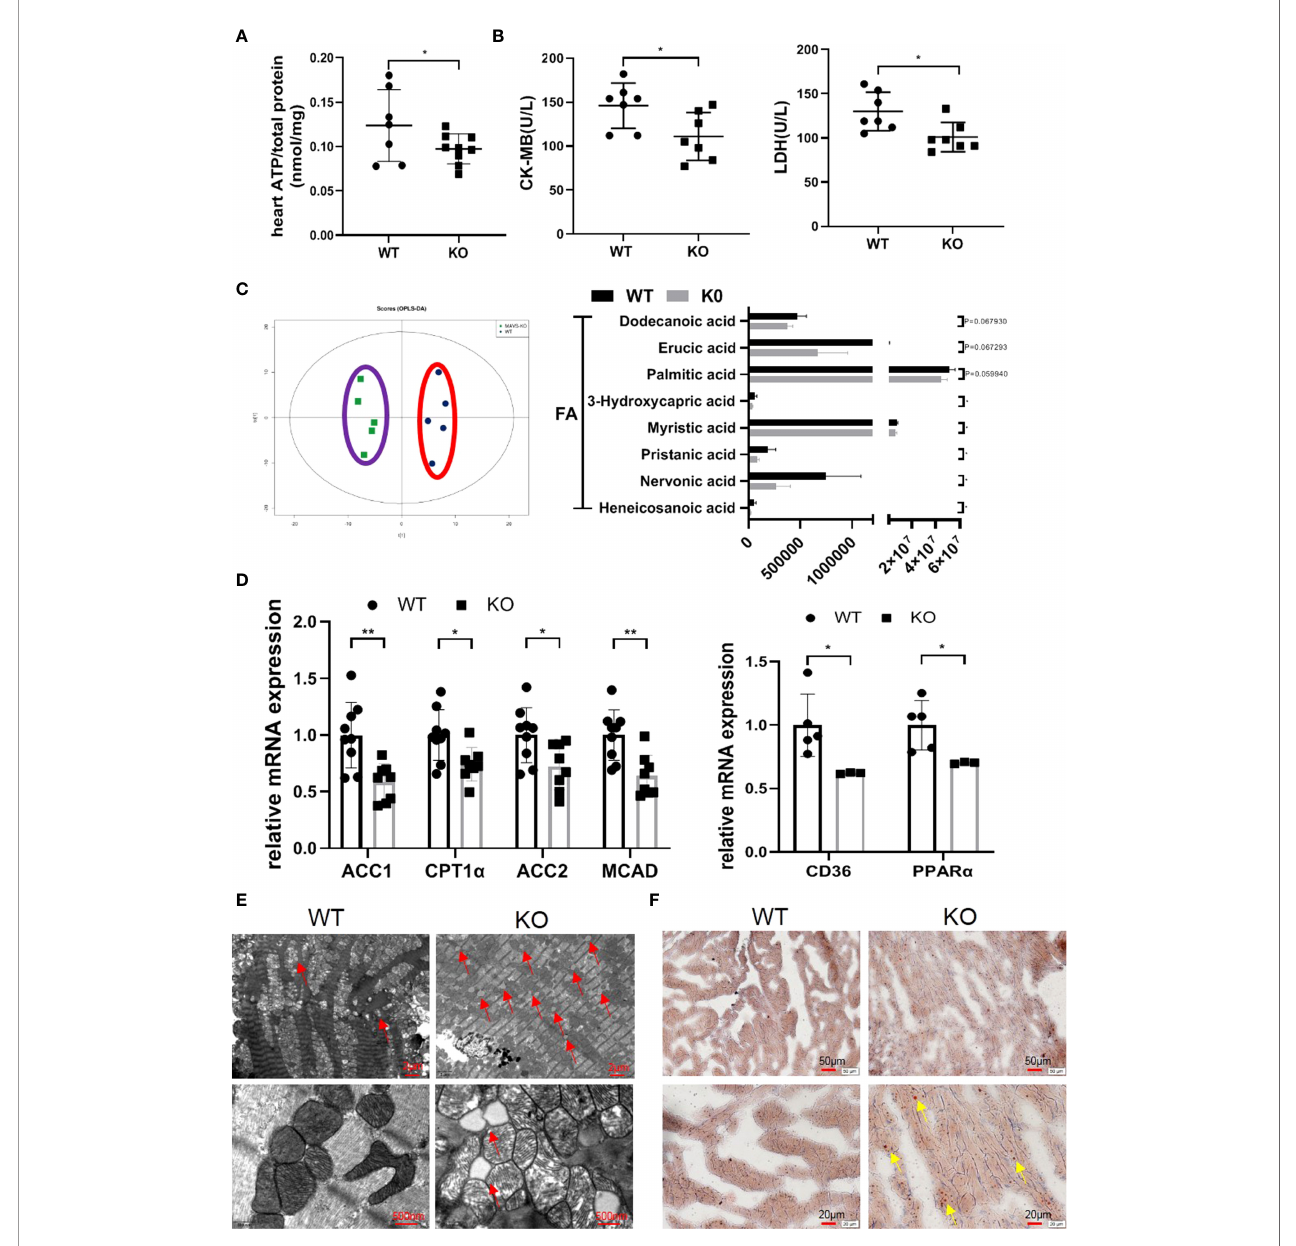
FIGURE 3 | MAVS de fi ciency resulted in energy metabolism disorder by disturbing lipid metabolism. (A) . The ATP content in the hearts of MAVS -/- mice was lower than that in WT mice (n: WT=7, knockout [KO]=9). (B) . Serum CK-MB and LDH levels in WT and MAVS -/- mice (n: WT=7, KO=7). (C) . OPLS-DA analysis based on non-targeted metabolomics was conducted in the hearts of WT and MAVS -/- mice (n: WT=5, KO=5). The levels of some medium- and long-chain fatty acids were decreased in MAVS -/- mice (n: WT=5, KO=5). (D) . RT-qPCR analysis showed downregulation of fatty acid metabolism related genes (ACC1/2, CPT1 a , MCAD) in the hearts of MAVS -/- mice (n: WT=9, KO=8), reduced expression of CD36 and PPAR a (n: WT=5, KO=3). (E) . Representative TEM images of hearts from WT and MAVS -/- mice (Upper panel, scale bar: 2 µm; Lower panel, scale bar: 500 nm, red arrow: lipid droplets). (F) . Representative Oil Red O-stained images of hearts from WT and MAVS -/- mice (Upper panel, scale bar: 50 µm; Lower panel, scale bar: 20 µm, yellow arrow: lipid droplets). The quantitative results are shown as the means ± SEM (*P < 0.05 and **P <